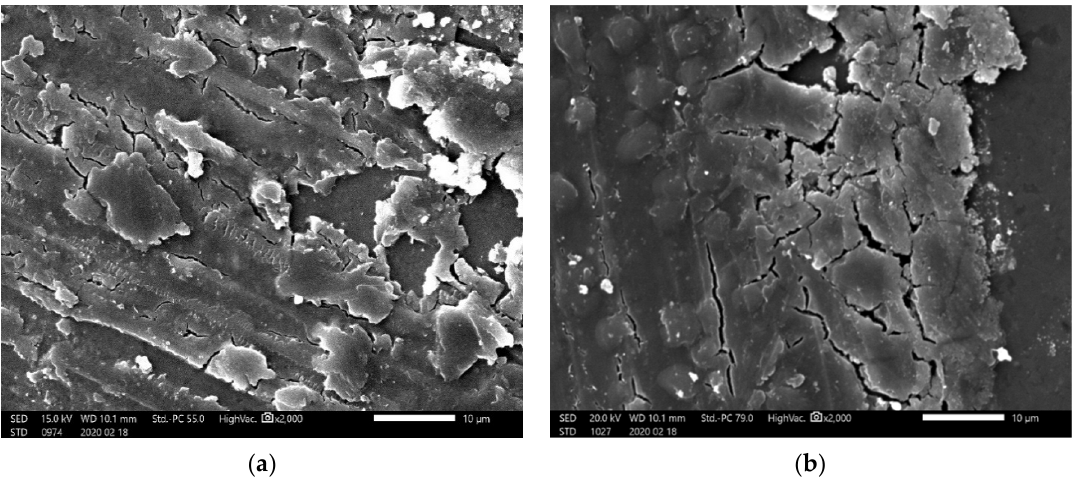
Figure 8. SEM-SE images of wear track details for ( a ) Al 2 O 3 -15SiC ( b ) Al 2 O 3 -25SiC composites showing microcracking and local flaking.